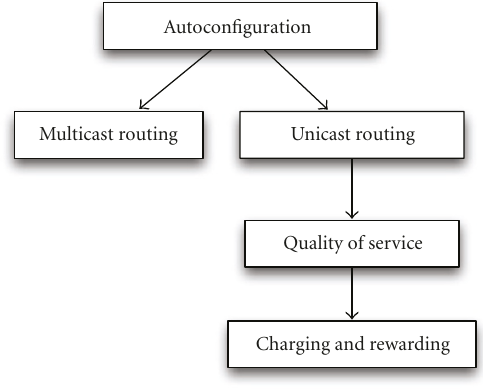
Figure 2: Functional